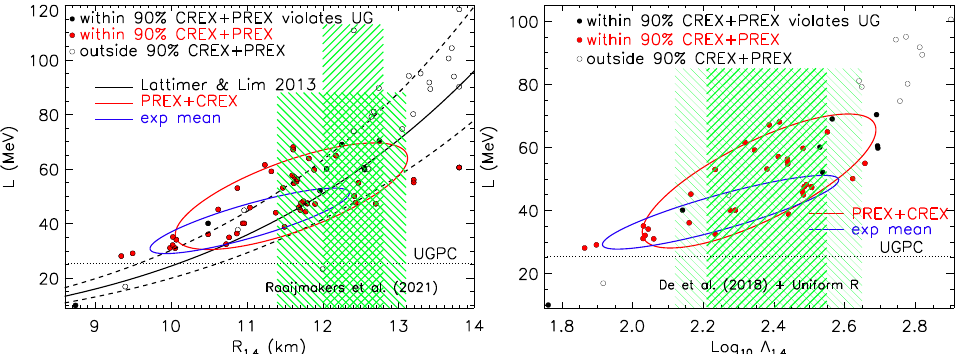
Figure 11. The same as Figure 10 except showing R 1.4 versus L ( left panel ) and Λ 1.4 versus L ( right panel ) for subsets of forces from Refs. [18,37,60,63,64]. Black solid and dashed curves in the left panel show the R 1.4 − L correlation and standard deviations derived as in the text. The shaded green bands are 68% and 95% confidence intervals from a joint analysis of GW170817 and PSR J0030+0451 and PSR J0740+6620 by Ref. [120] ( left panel ) and from GW170817 Bayesian analyses posteriors [21], corrected for Λ priors chosen so as to reflect uniform R priors ( right panel